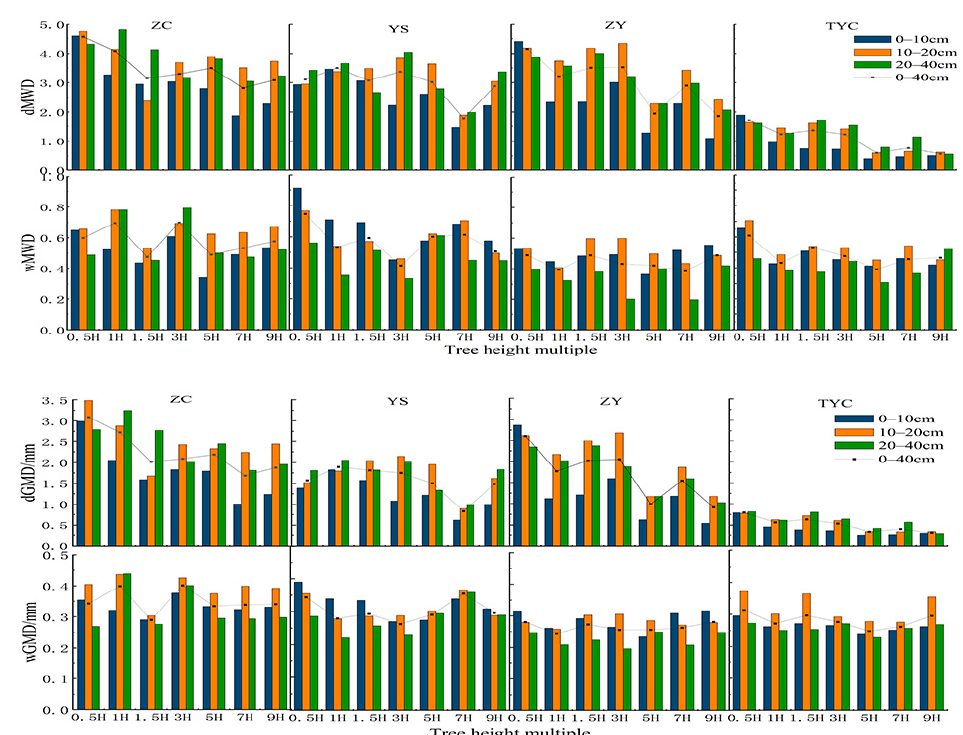
Figure 7. Change in the stability of soil aggregates (dMWD, dGMD, wMWD and wGMD) at different distances from shelterbelts.